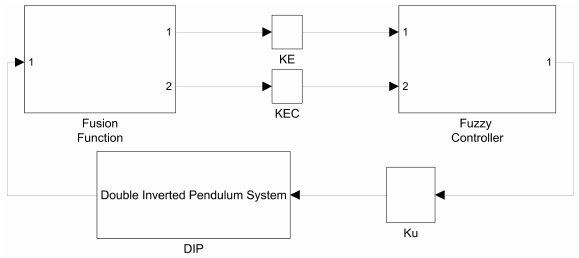
Figure 14. Closed-loop system.